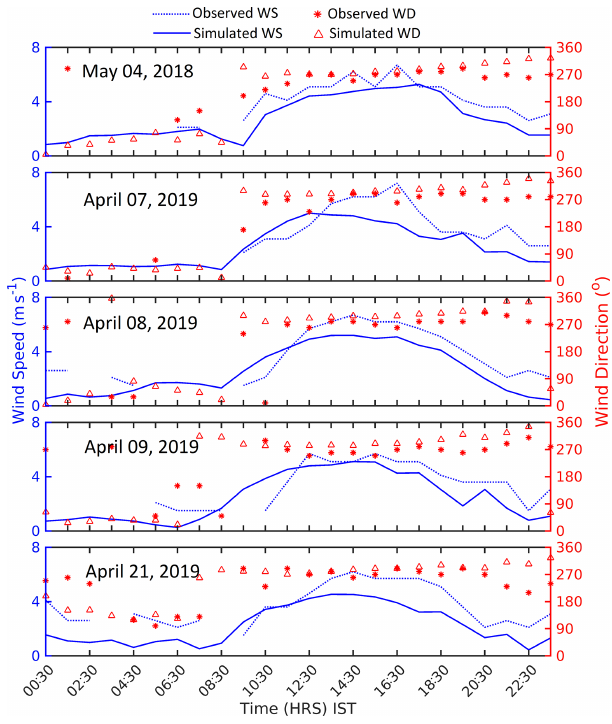
Figure 2. Time series of simulated (CTRL case) and observed wind speed (WS) and wind direction (WD) at 11.27m for the 5 sea breeze days.